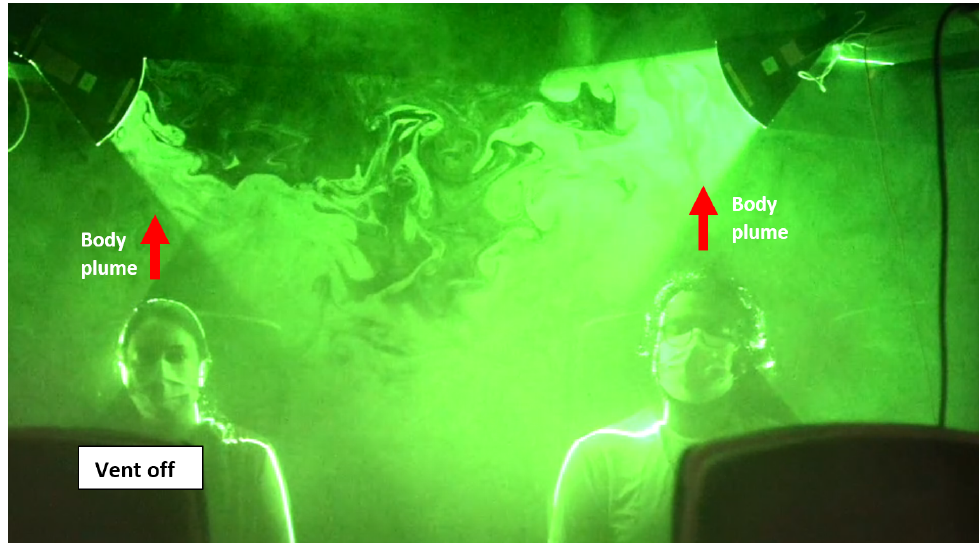
Figure 11. Snapshot of flow visualisation experiment at the middle of carriage during unventilated conditions. Red arrows indicate direction of persistent air flow.